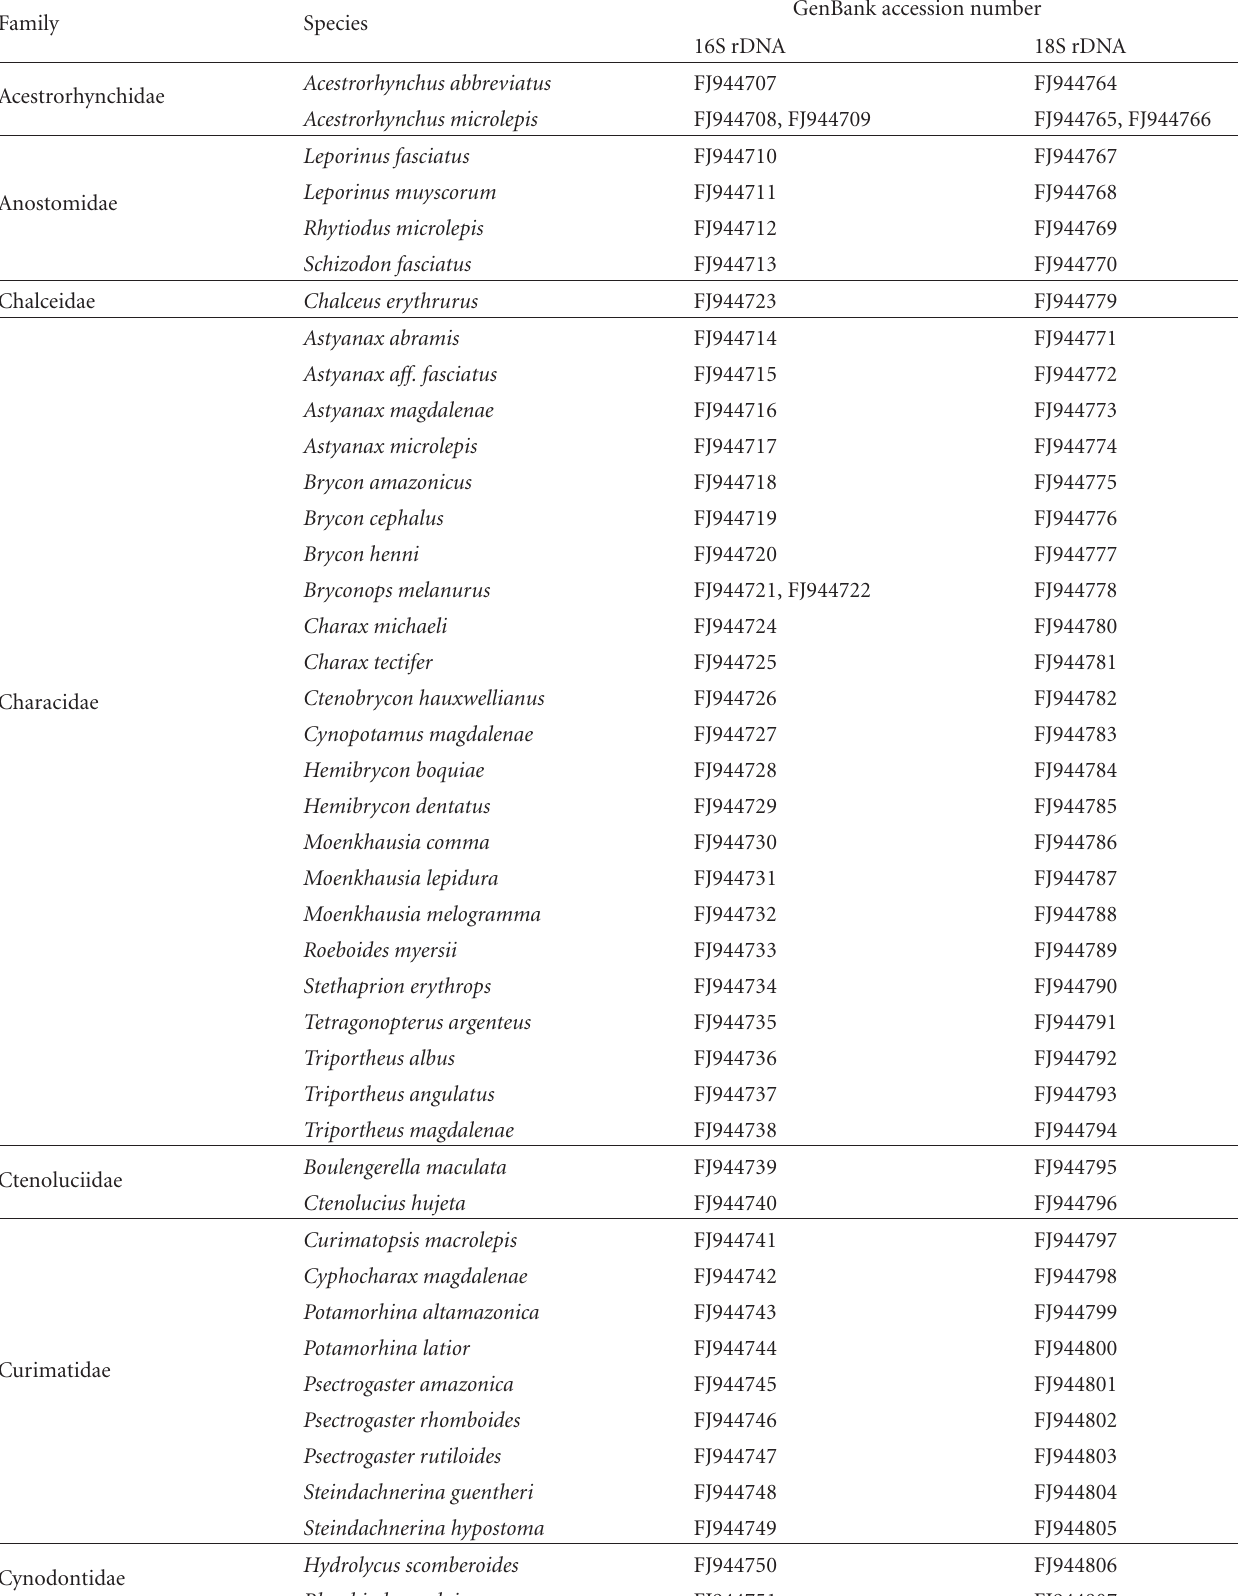
Table 2: Examined families, genera and species along with GenBank accession numbers for sequences analyzed in this study.